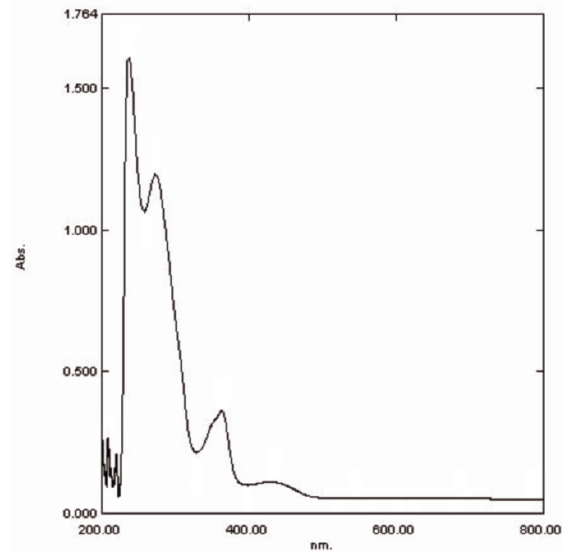
Figure 2. Electronic spectrum of [Ru(CO)(PPh